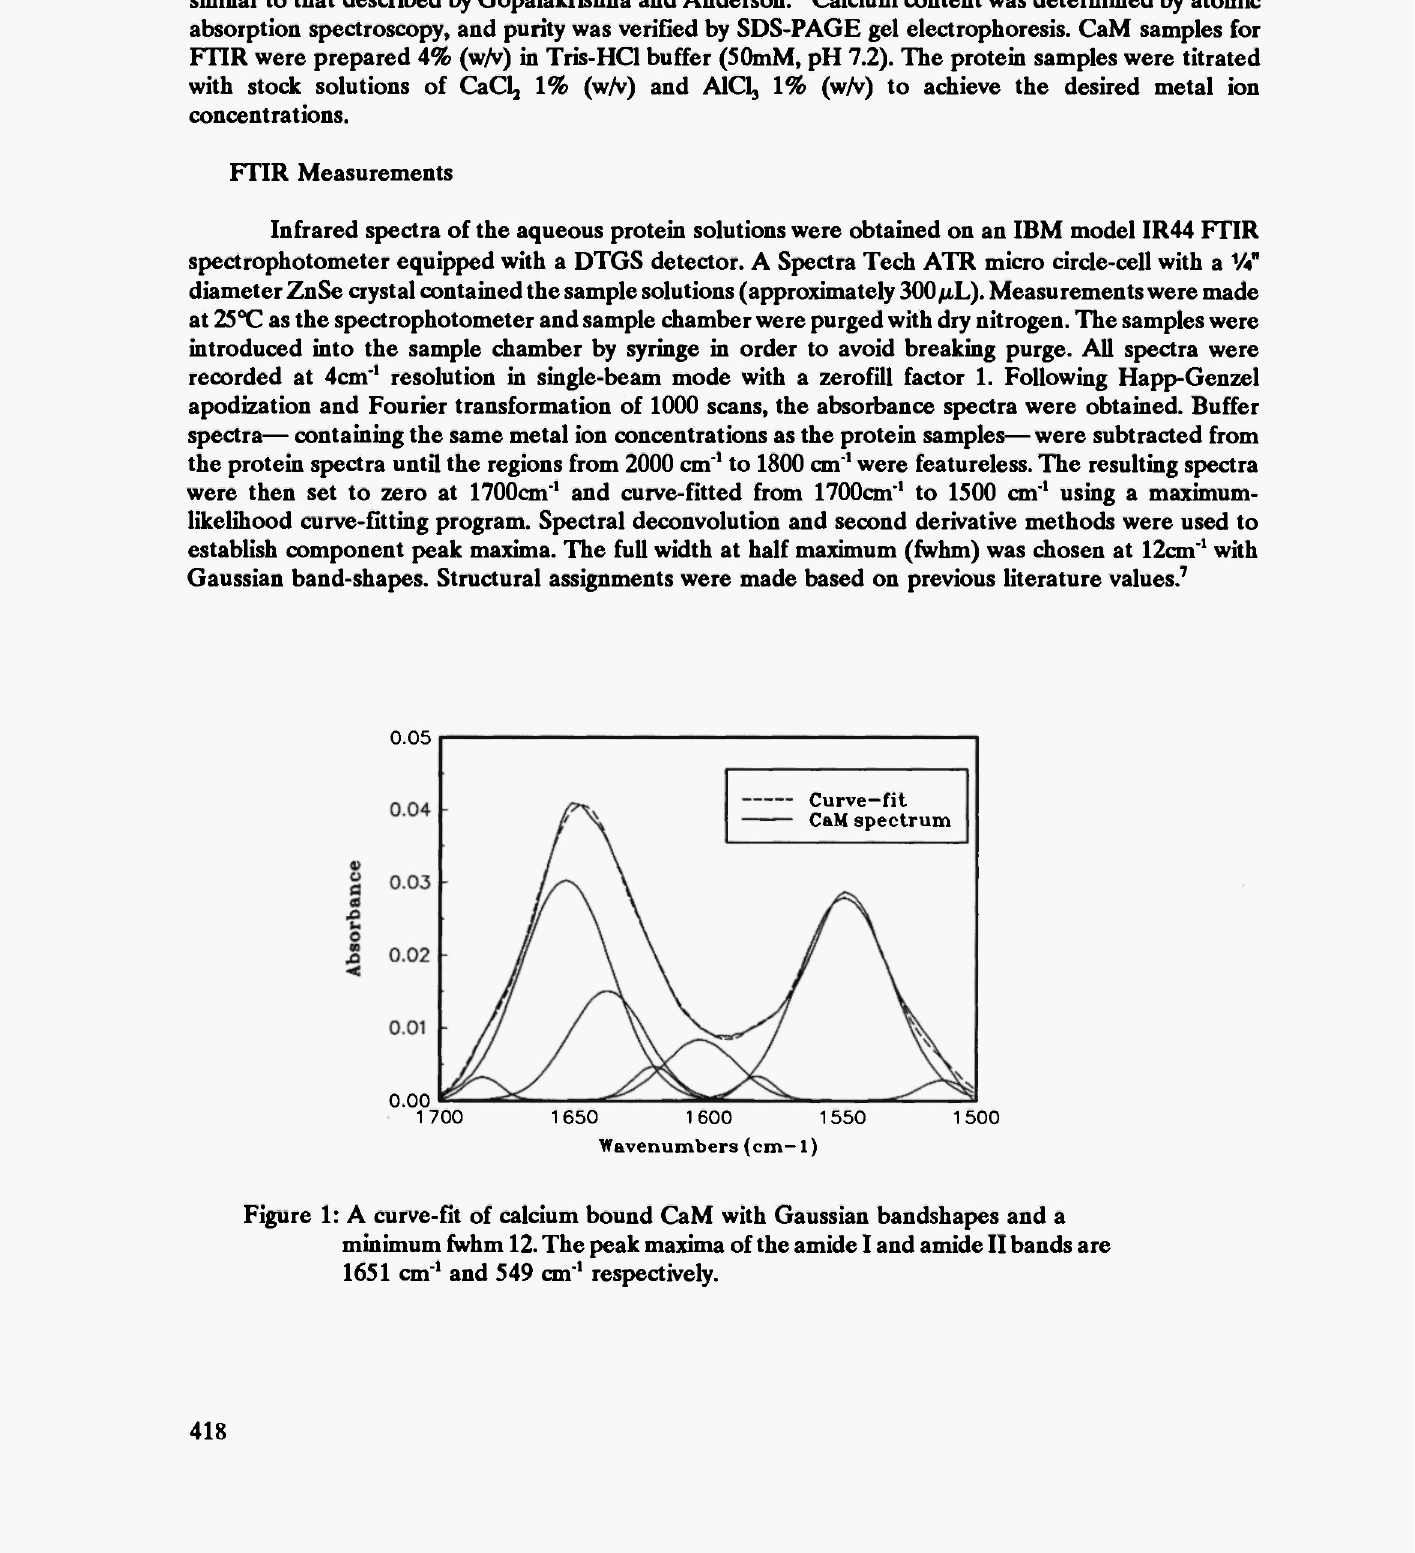
Figure 1: A curve-fit of calcium bound CaM with Gaussian bandshapes and a minimum fwhm 12. The peak maxima of the amide I and amide II bands are 1651 cm" 1 and 549 cm' 1